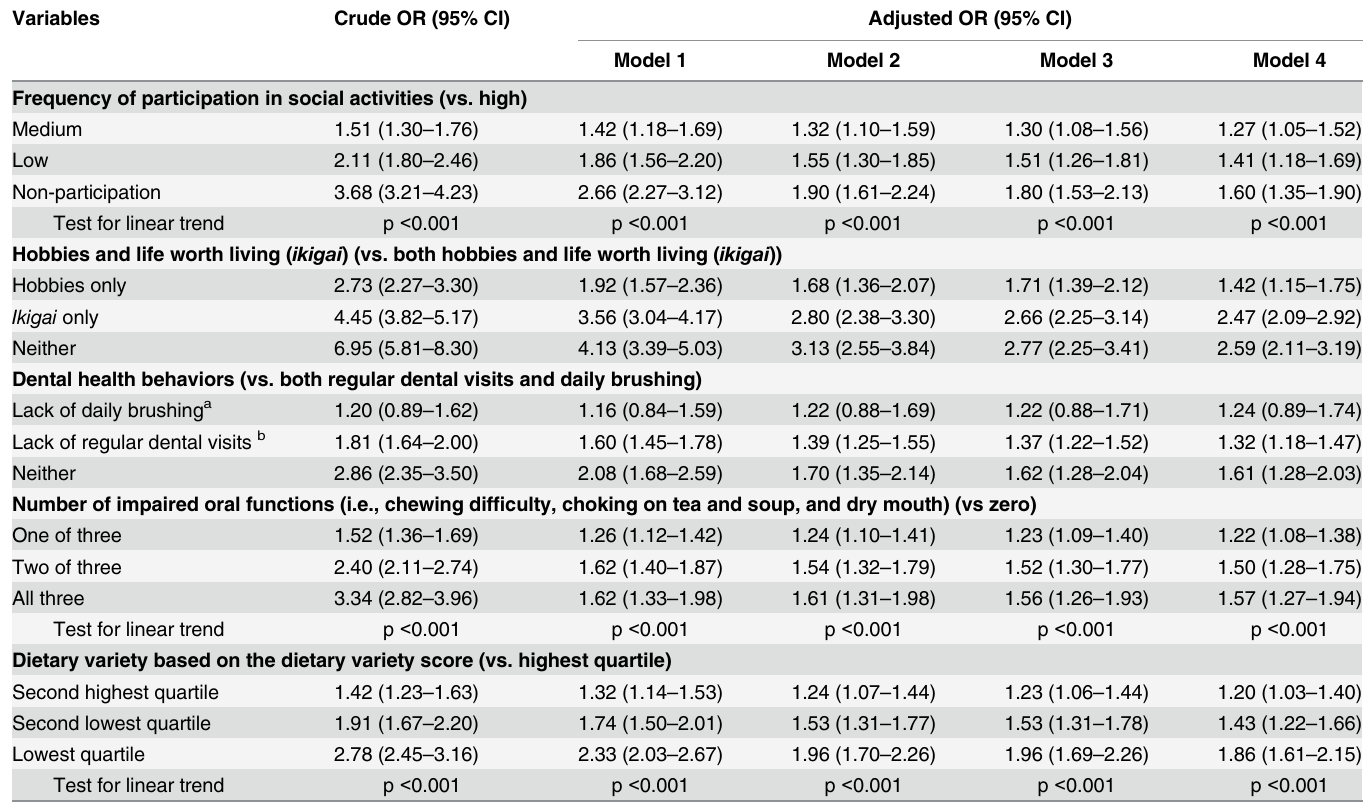
Table 4. Odds Ratios of Poor Intellectual Activity (Score < 4) for Psychosocial Conditions and Oral Health: Multiple Logistic Regression